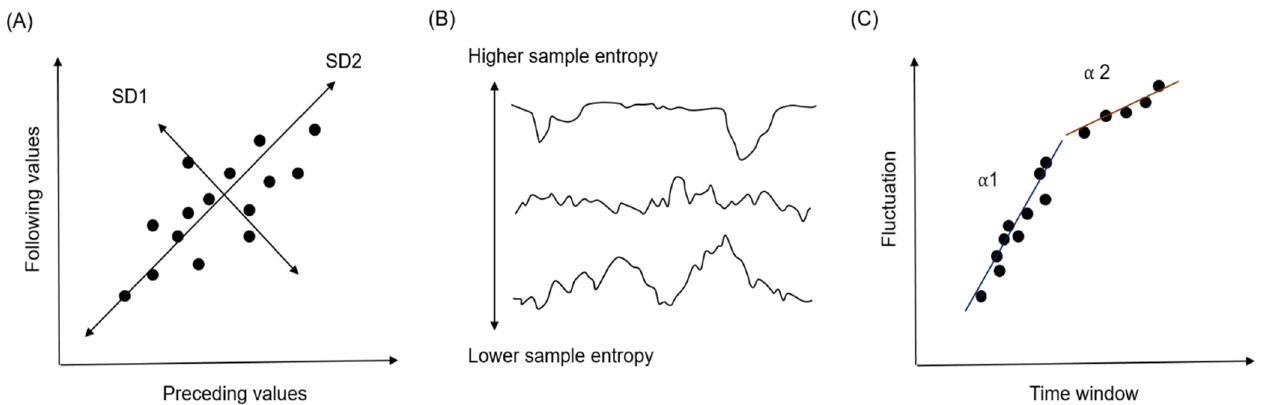
Figure 3. Methods used for the feature extraction process. ( A ) Poincaré plot, ( B ) Sample entropy, and ( C ) Detrended fluctuation analysis. All three approaches evaluate the level of variability in time-series data. For numerical values, the Poincaré plot method was used; for waveform data, sample entropy and detrended fluctuation analysis methods were used.